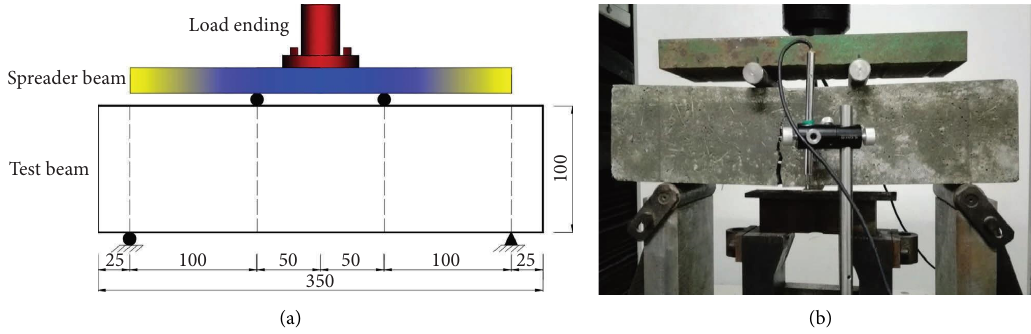
Figure 3: ARGFRC fexural test: (a) schematic diagram (unit: mm); (b) four-point bending test.